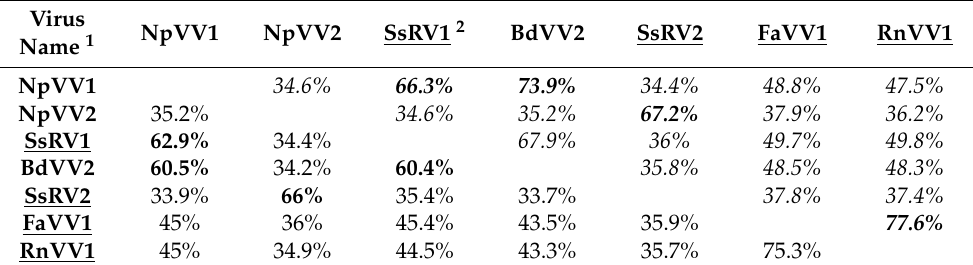
Figure 5. Unrooted phylogenetic tree reconstructed from the alignment of the amino acid sequences of the RdRp of Victorivirus representative members. The tree was constructed by the neighbor-joining method and the statistical significance of branches was evaluated by bootstrap analysis (1000 replicates). Only bootstrap values above 70% are indicated. The scale bar represents 5% amino acid divergence. Neofusicoccum parvum victorivirus 1 and 2 are in bold and indicated by black squares. Table 4. Percentage of amino acid identity between representative members of the genus Victorivirus in the RdRp and CP .